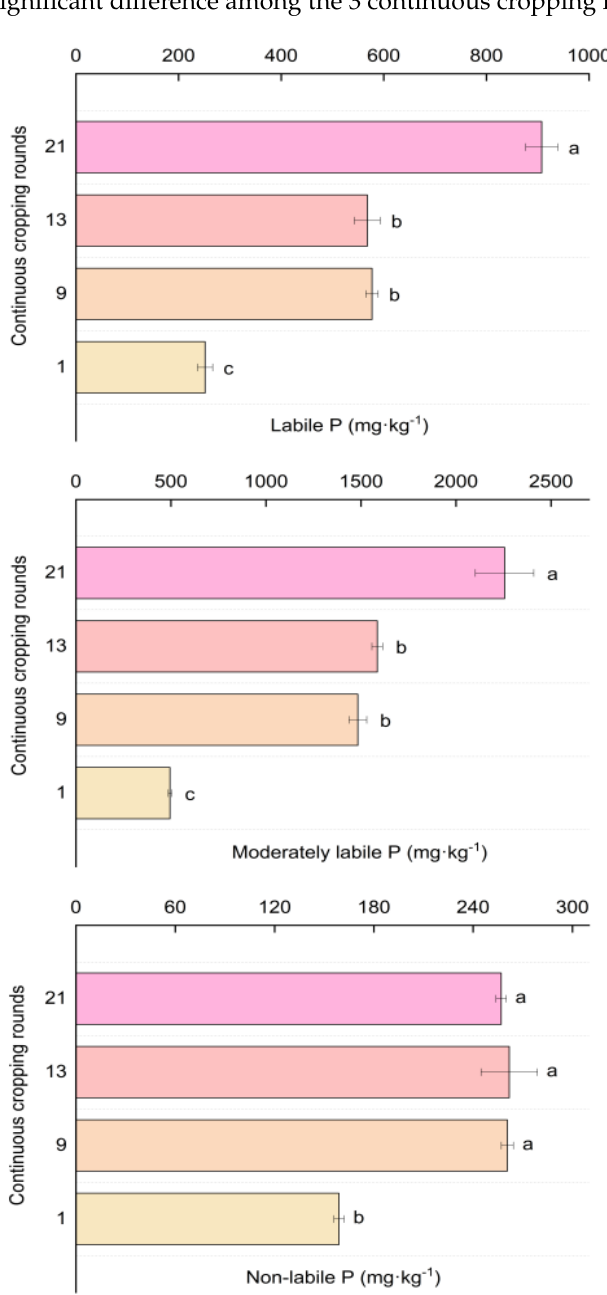
Figure 3. Changes of P fraction contents in the greenhouse soil after long-term continuous cropping. The different letters indicate the significant differences among the treatments on p <